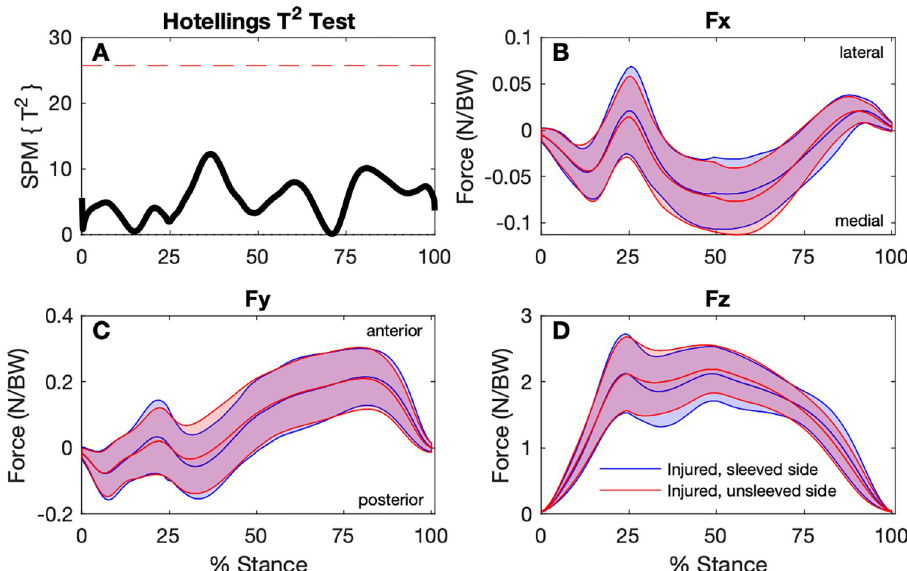
Fig 3. Comparison of ground reaction forces during the stance phase of the step-down hop for the sleeved and unsleeved conditions for the ACL injured sides (n = 30). A: SPM Hotellings T 2 test trajectory, dashed red line indicates adjusted significance criterion; B to D: x (lateral/medial), y (anterior/posterior), and z (vertical) component curves (mean and ± 1 standard deviation bands),